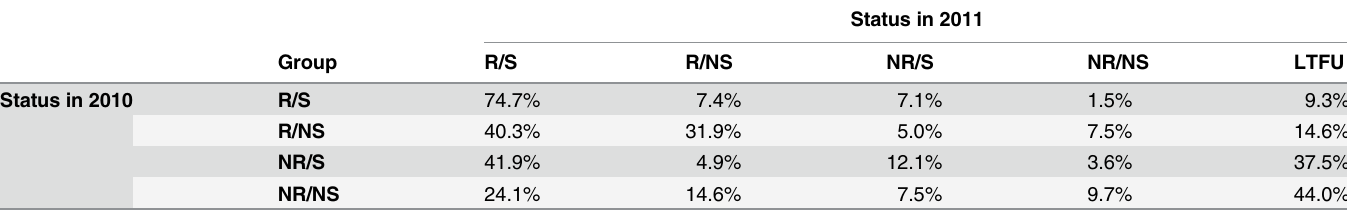
Table 4. Predicted Probabilities for Retention in Care and Viral Suppression Status in Calendar-Years 2011 by Retention/Suppression Status in Calendar-Year 2010, from Multinomial Regression